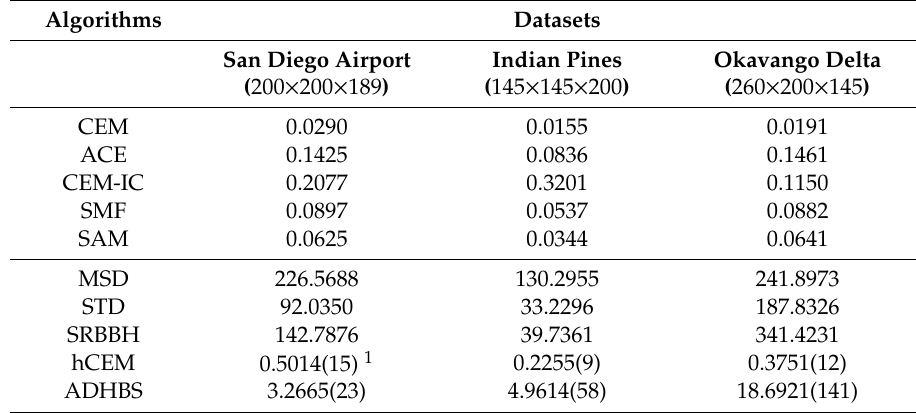
Table 4. Time consumed for the di ff erent methods of the three datasets (keep four decimal places, specified in